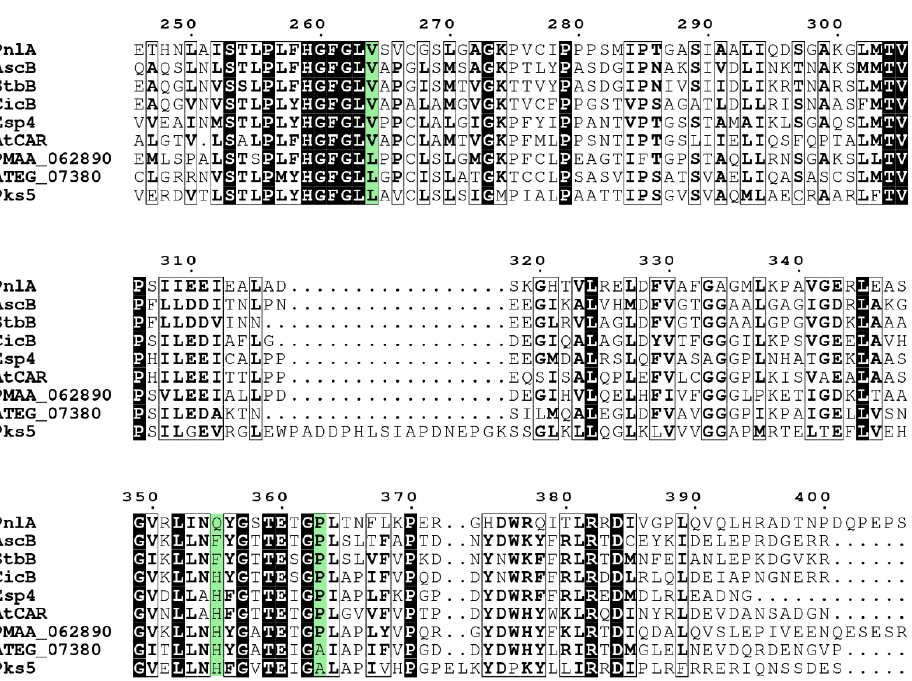
Figure 4. Alignment of fungal CARs located in clade VI, including PnlA, StbB [13], AscB [21], CicB [19], Esp4 [14], AtCAR [17], PMAA_062890, ATEG_07380 and Pks5 [20]. See alignment of the whole sequences in Figure S5.